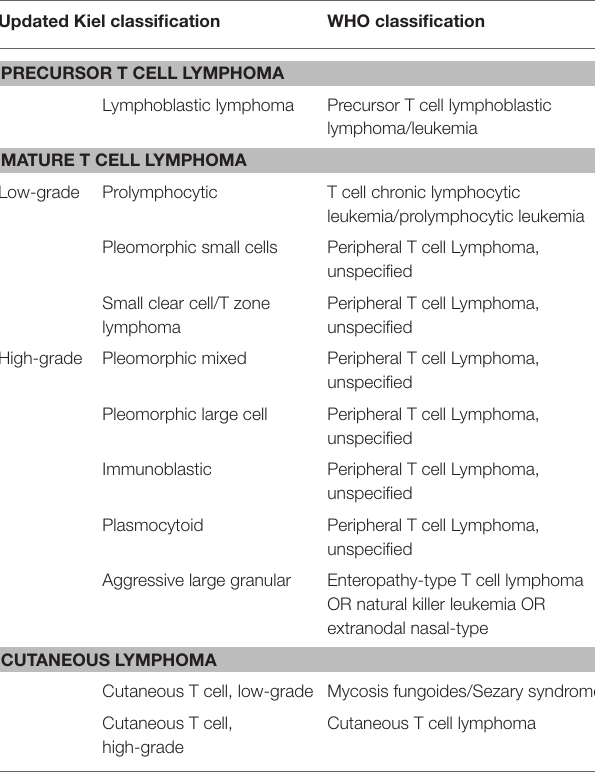
TABLE 2 | Common antibodies used for the characterization of T cells in dog and expected